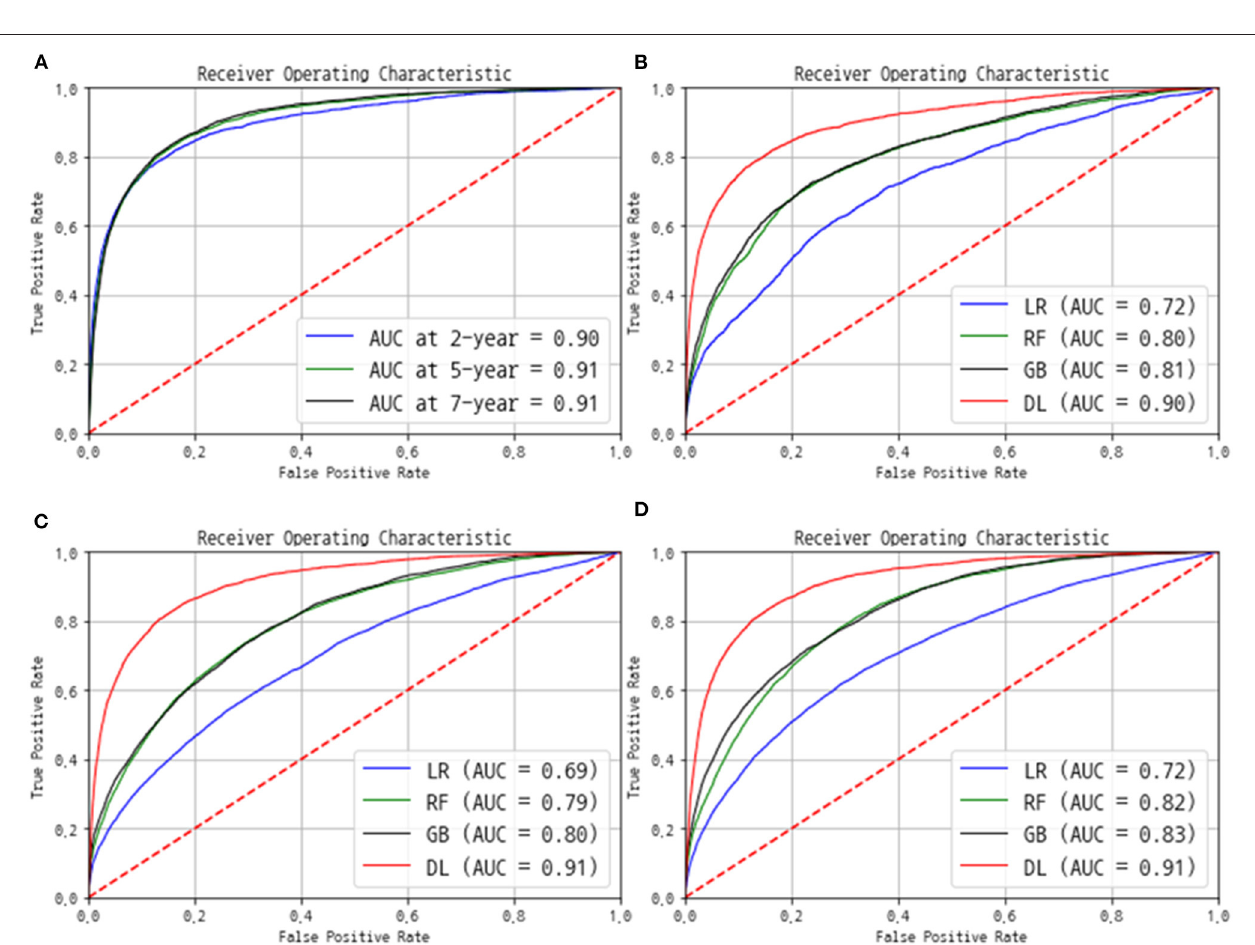
FIGURE 3 | Performance of the final model in terms of the receiver operating characteristic (ROC) curves. (A) The ROC and area under the ROC curve (AUC) were evaluated using the separated test group at each 2-, 5-, and 7-year point. The comparison of ROC and AUC of logistic regression (LR), random forest (RF), gradient boosting (GB), and our deep-learning (DL) models at (B) 2 year, (C) 5 year, and (D) 7 year point.